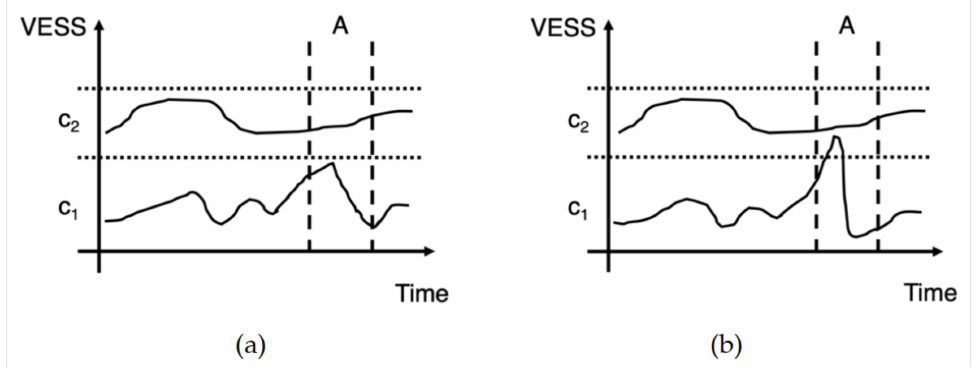
Figure 2. Comparison of the virtual energy storage system (VESS) operation according to P0 and P1 : ( a ) VESS operation for participants 1 and 2 by P0 ; ( b ) VESS operation for participants 1 and 2 by P1 .